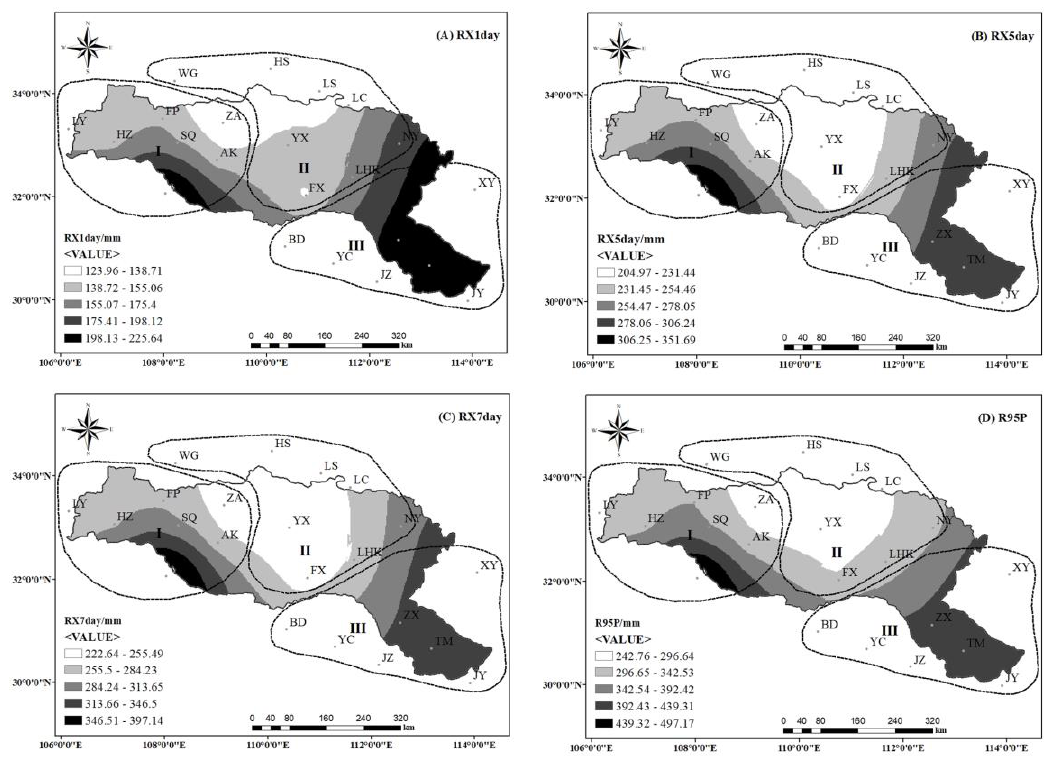
Figure 8. Spatial mapping of estimated annual precipitation extremes in HJRB when return periods are 100 years using L-moments based regional frequency analysis approach, ( A ): RX1day; ( B ): RX5day; ( C ): RX7day; ( D ): R95P.